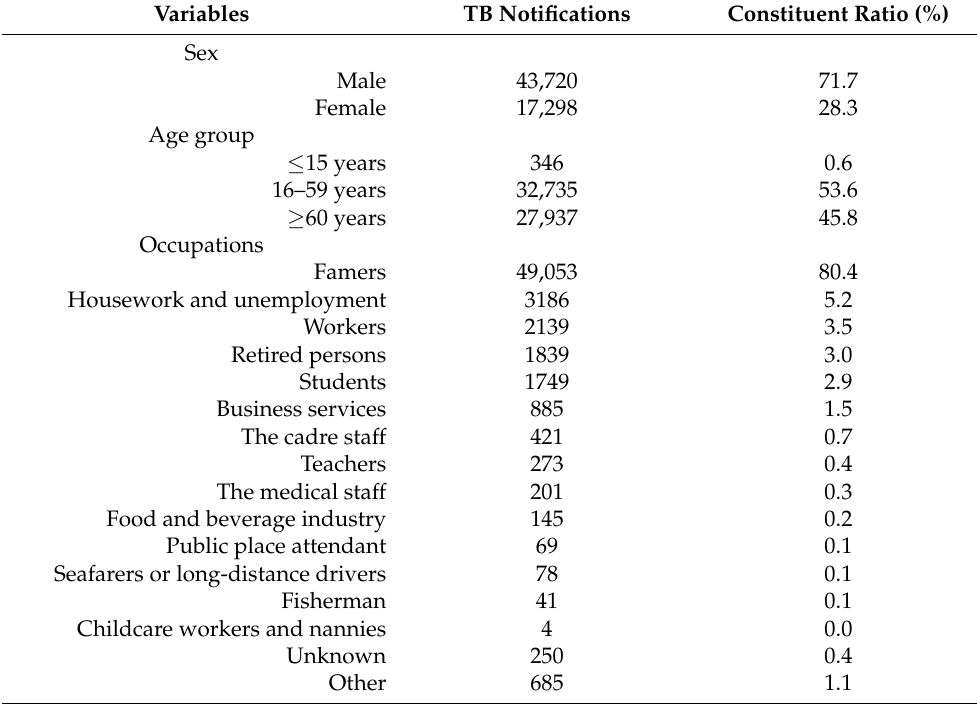
Table 1. The TB notifications in Changde City, Hunan Province,